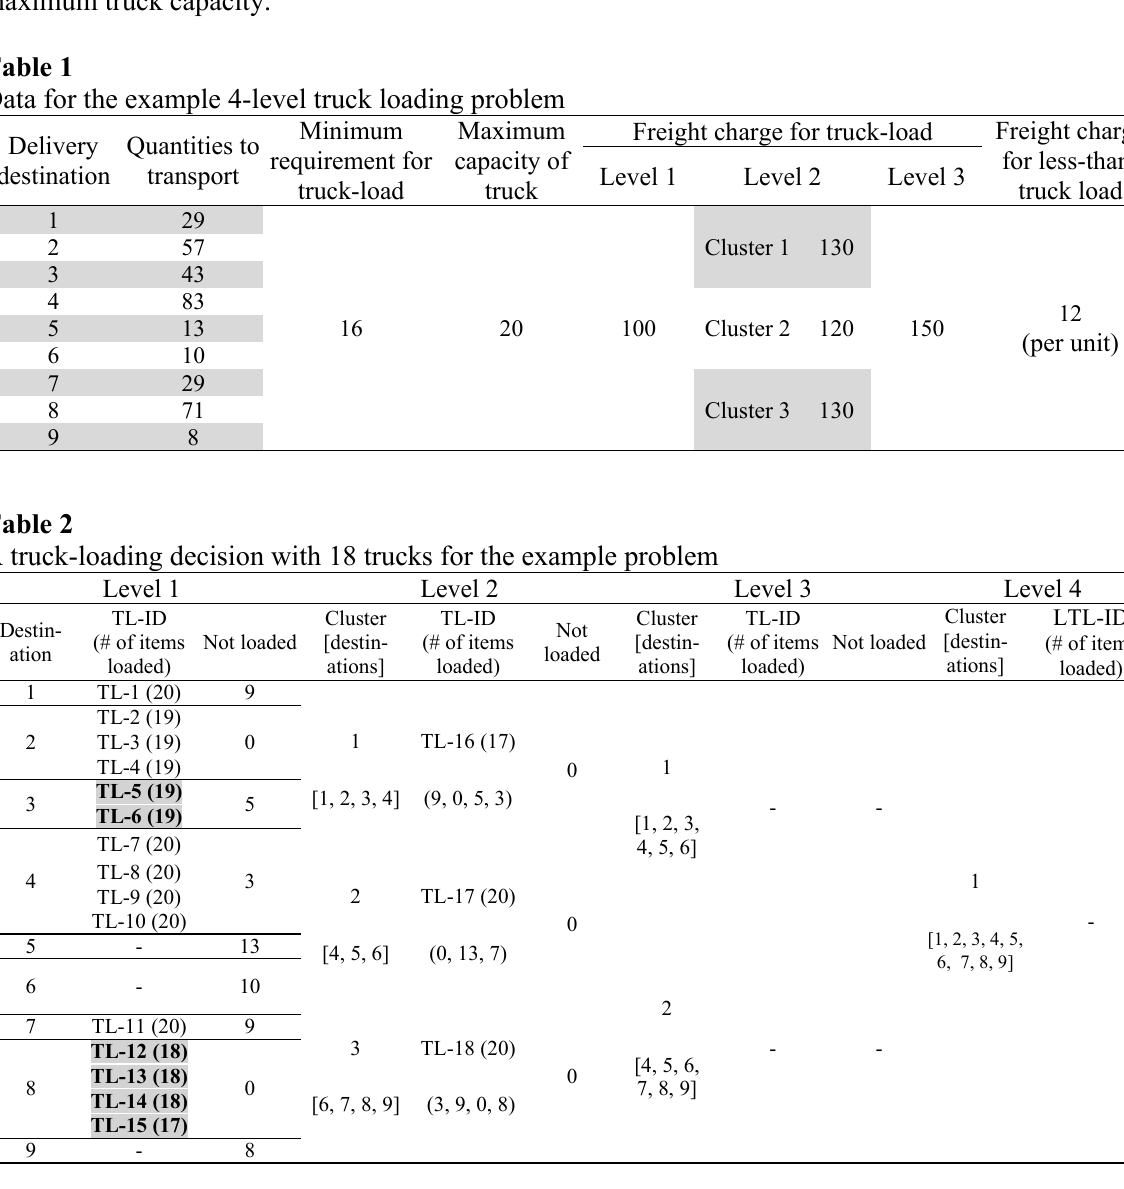
Table 2 and Fig. 2 show a truck-loading decision by the sequential batching process and its graphical representation. Fifteen truckloads (from TL-1 to TL-15) are formed at Level 1, while each truckload contains only items for one destination. We call them homogeneous truckloads. For items not loaded